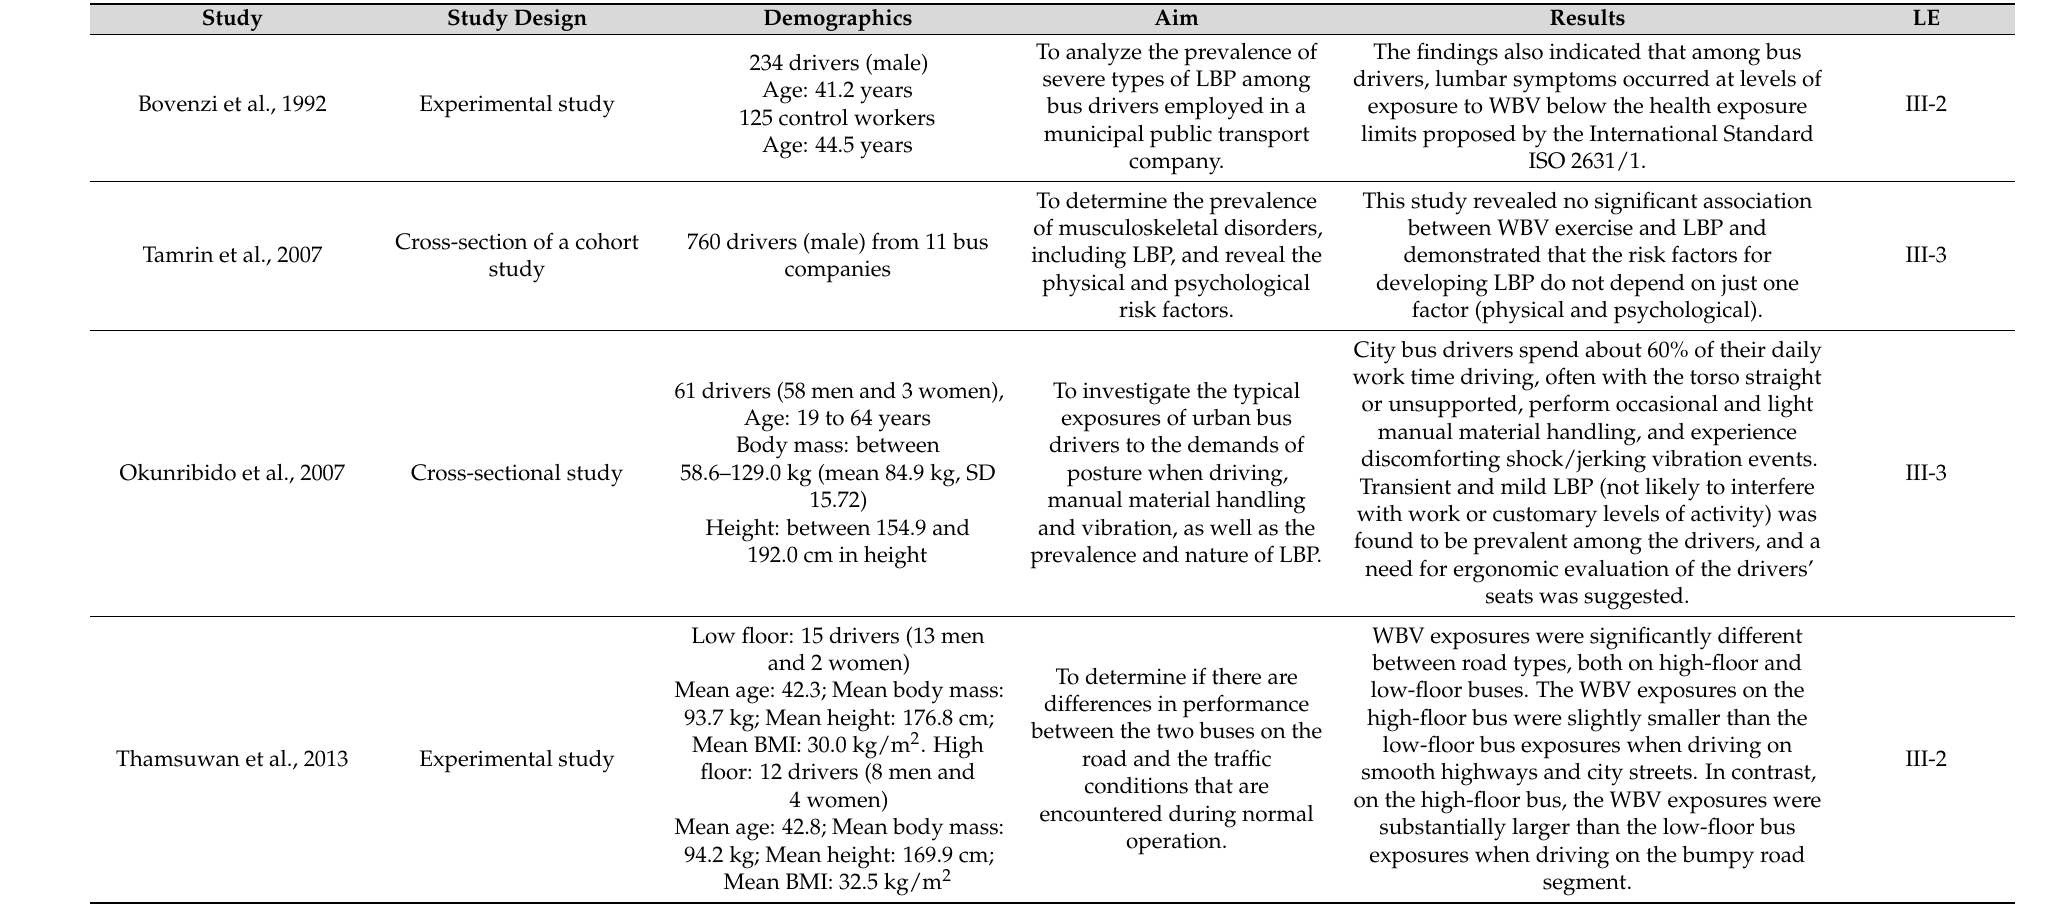
Table 1. Characteristics of the included studies and the level of